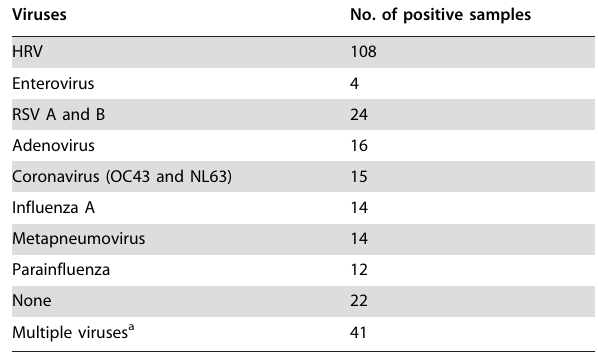
strains (W7, W15, W24, W28 and W36) clustered in a distant branch near serotypes 12, 45 and 78; 7 strains (W6, W10, W11, W12, W17, W23 and W25) in distant branch near serotypes 51, 65 and 71; strains W8, W9, W20 and W38 formed a new branch, and strain W33 was the lone member of a new branch. Moreover, 9 Table 2. Viruses detected in nasal samples of 26 infants with Viruses No. of positive samples HRV